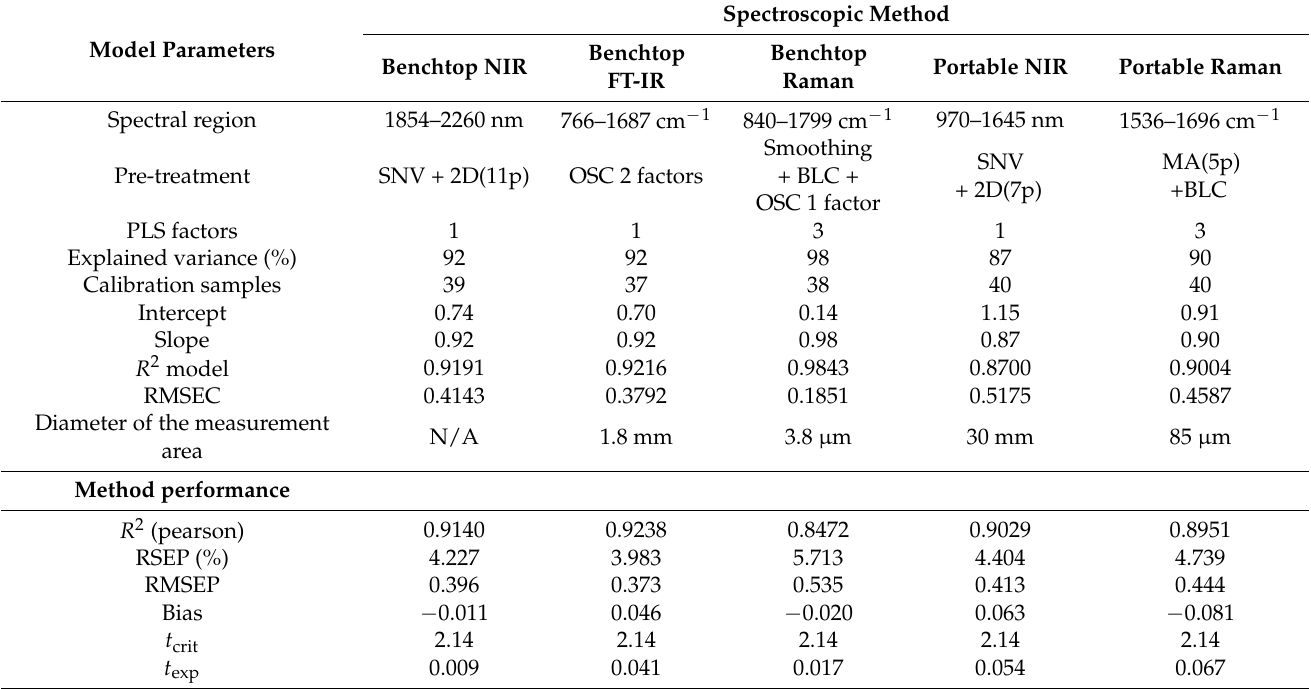
Table 2. PLSR models and performance of all the methods.